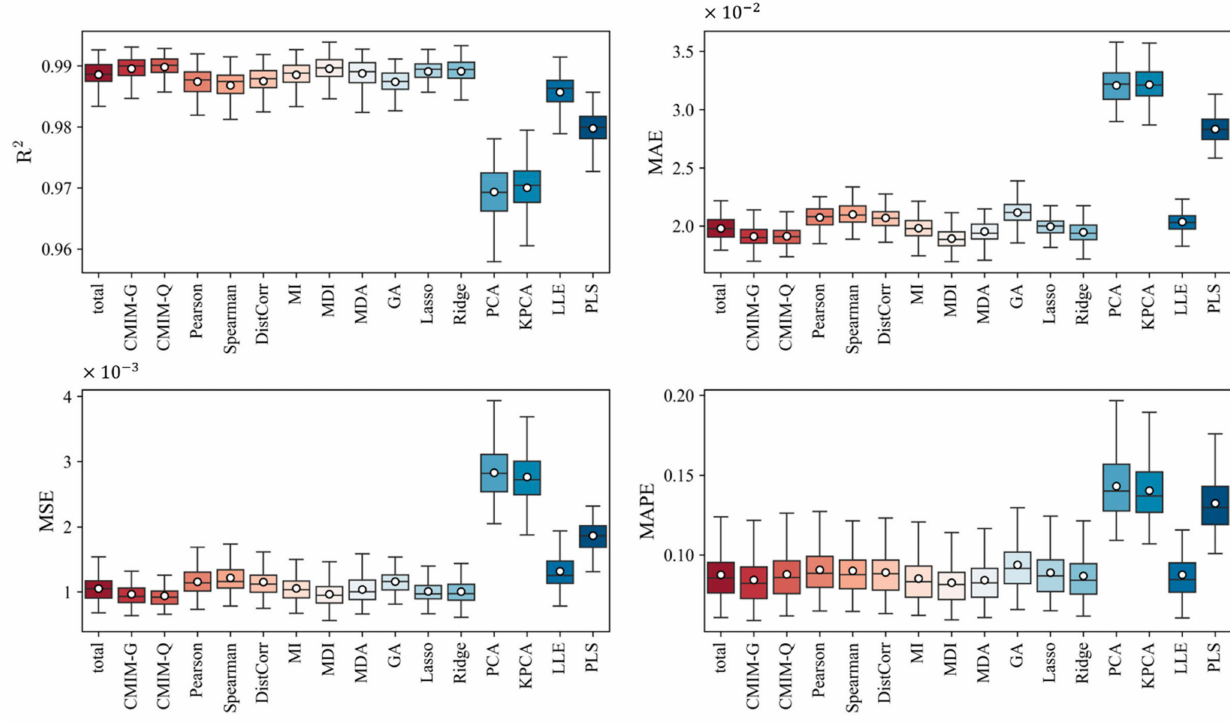
Figure 8. Comparison of metrics obtained by different methods with RF on Y HD